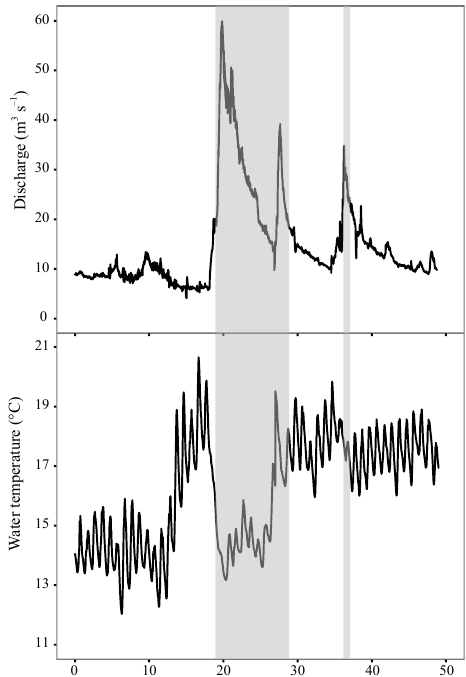
Figure 4. (a) Discharge and (b) water temperature in the river Ruhr during the study period in summer 2014. Trend in water temperature during study period is exemplarily shown for the second restored reach